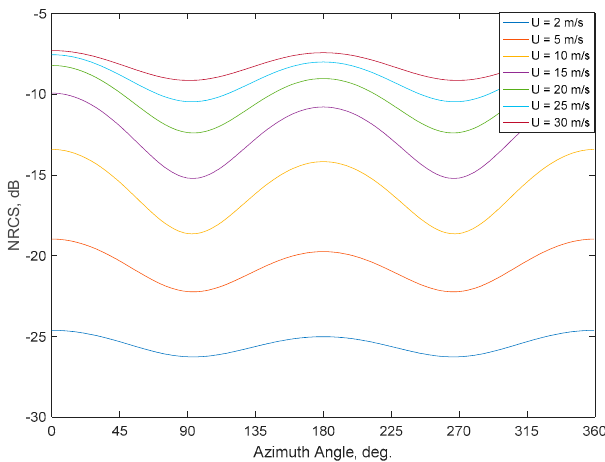
Figure 5. C-band VV polarization azimuthal curves by CMOD7 GMF for wind speeds of 2, 5, 10, 15, 20, 25, and 30 m/s at the incidence angle of 41.8°.